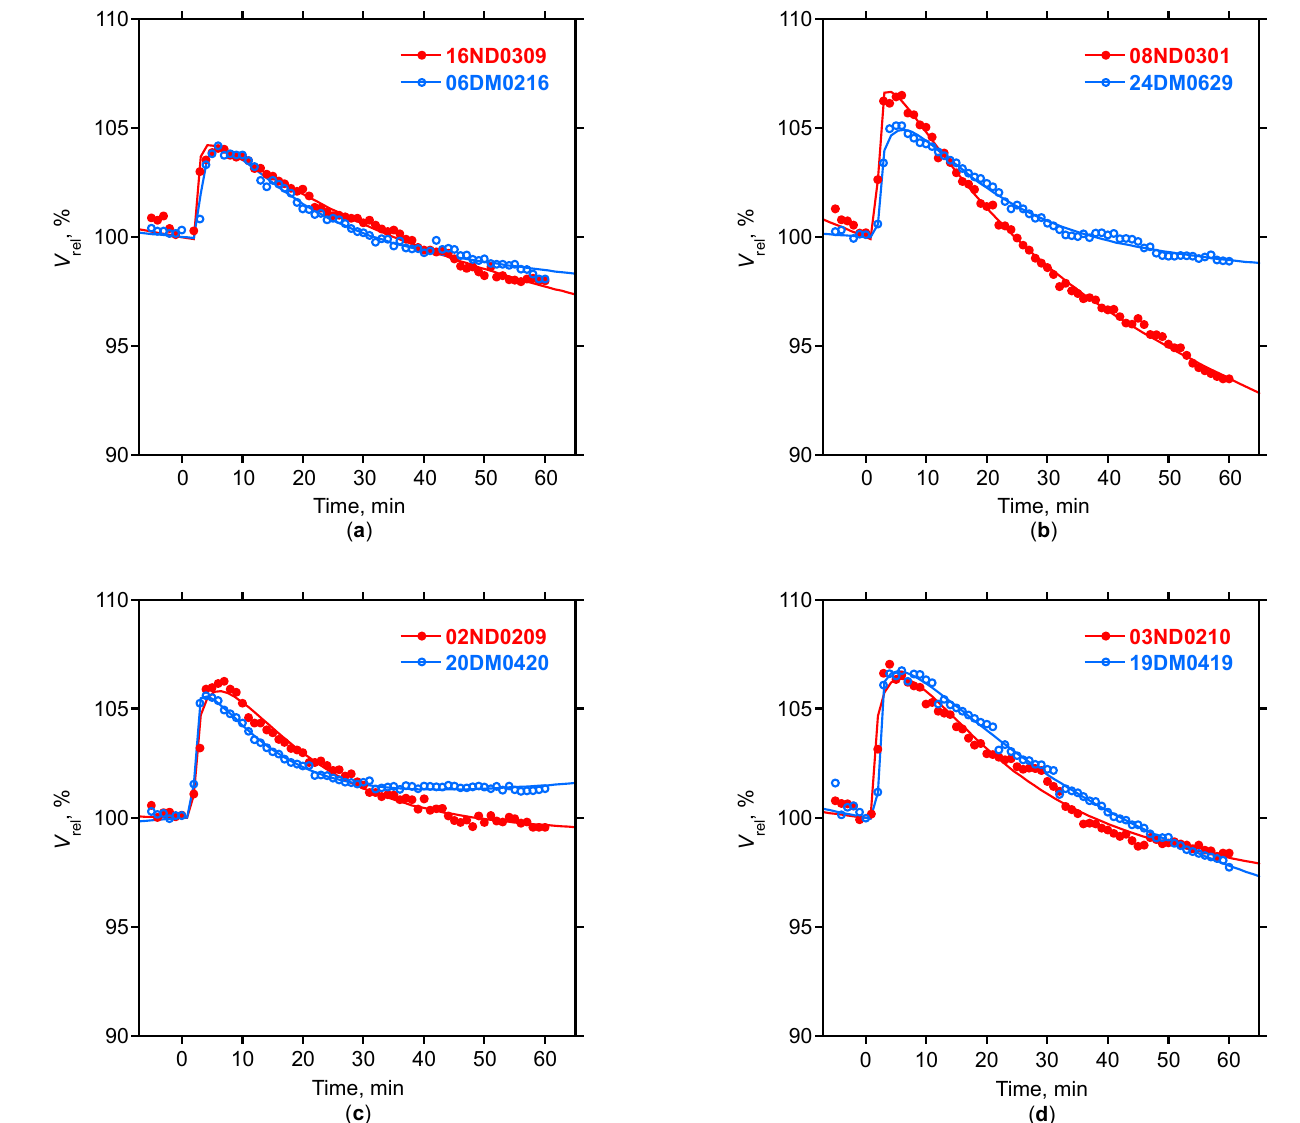
Figure 2. Relative blood volume modeling. Relative blood volume data (symbols) and corresponding non-linear model fits (full lines) of eight dilutions obtained in four subjects with (open symbols) and without (full symbols) T2D. The legends refer to study numbers. Pearson correlation coefficients ( r ) and model parameters ( δ , A , α , ß , and k ) are provided for each study: ( a ) #16 (Without): r = 0.99, δ = 2.99, A = 4.56, α = 0.08, ß = 25.61, and k = 0.05; #06 (With): r = 0.99, δ = 2.99, A = 3.9, α = 0.31, ß = 11.19, and k = 0.03; ( b ) #08 (Without): r = 1, δ = 2, A = 7.35, α = 0.13, ß = 16.56, and k = 0.11; #24 (With): r = 1, δ = 1.99, A = 4.25, α = 0.37, ß = 11.72, and k = 0.02; ( c ) #02 (Without): r = 0.99, δ = 1.99, A = 4.98, α = 0.36, ß = 12.04, and k = 0.01; #20 (With): r = 1, δ = 2, A = 5.87, α = 0.17, ß = 11.02, and k = -